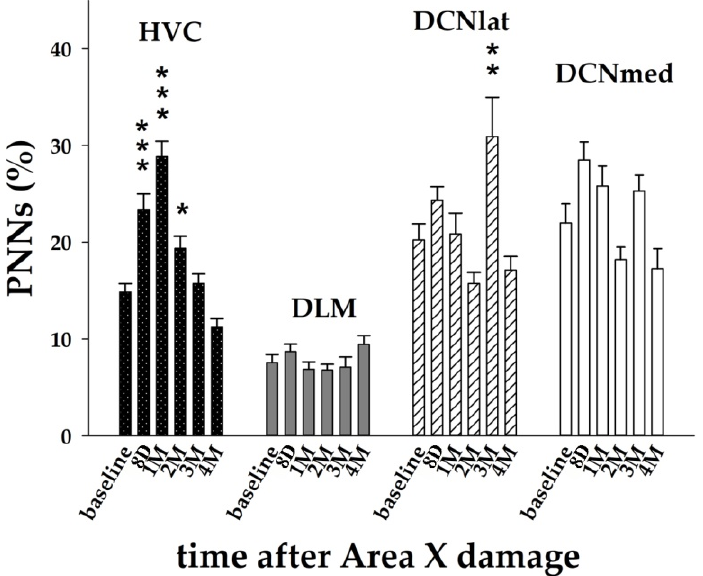
Figure 6. The expression of PNNs in HVC, DLM, DCNlat, and DCNmed after Area X lesion. Each bar represents mean and SEM. Two-way ANOVA was followed by the Holm–Sidak test with multiple comparisons vs. baseline group. * p < 0.05, ** p < 0.01, *** p < 0.001.